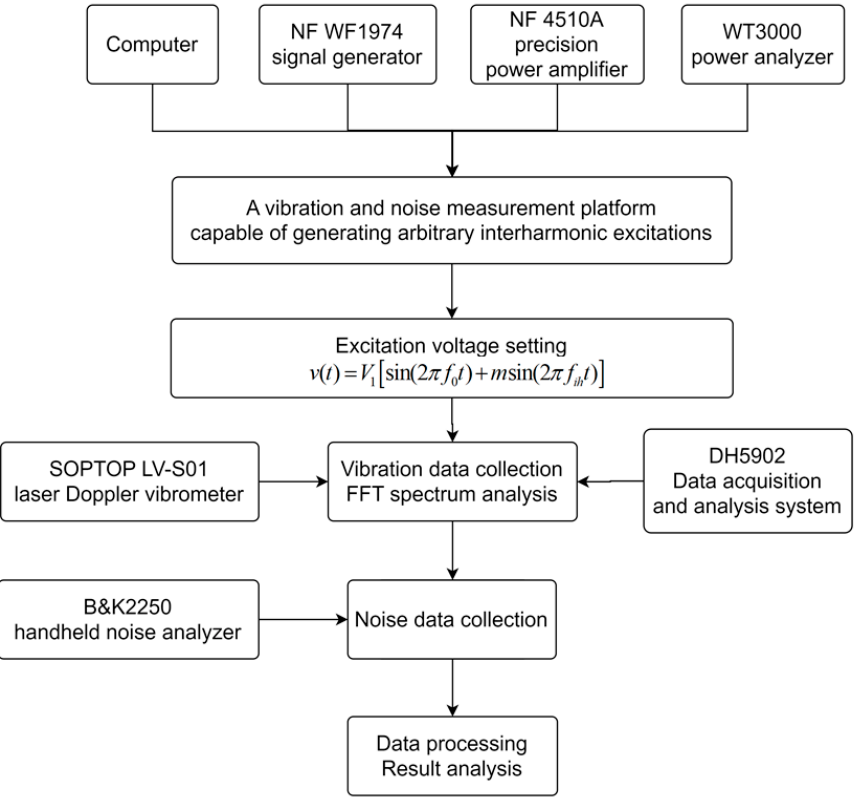
Figure 1. Experimental flow chart.